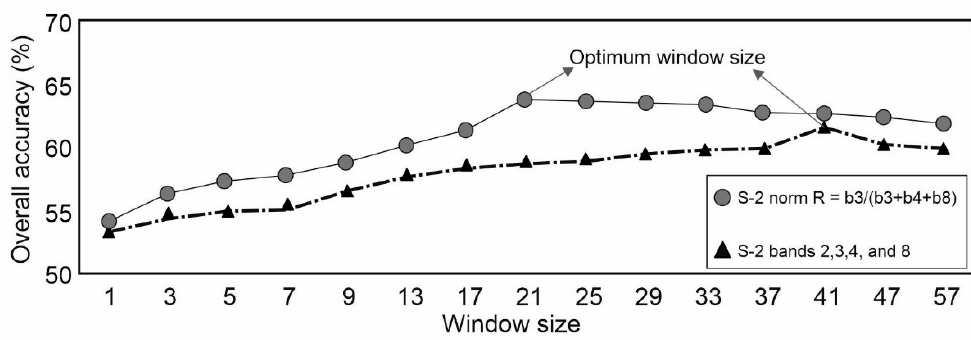
Figure 6. Overall accuracy of the OIF and norm R results using different window sizes.